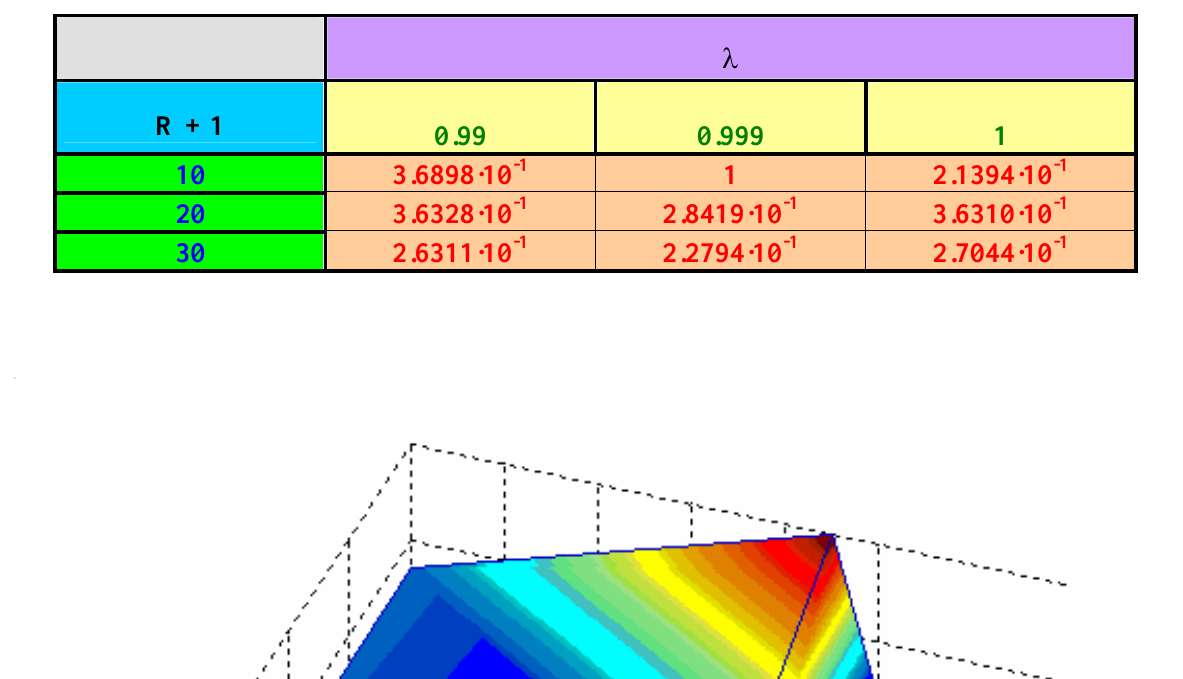
Table 1. Normalized ensemble-averaged mean-squared error of the filter for nine combinations of the length of the filter and the forgetting factor.